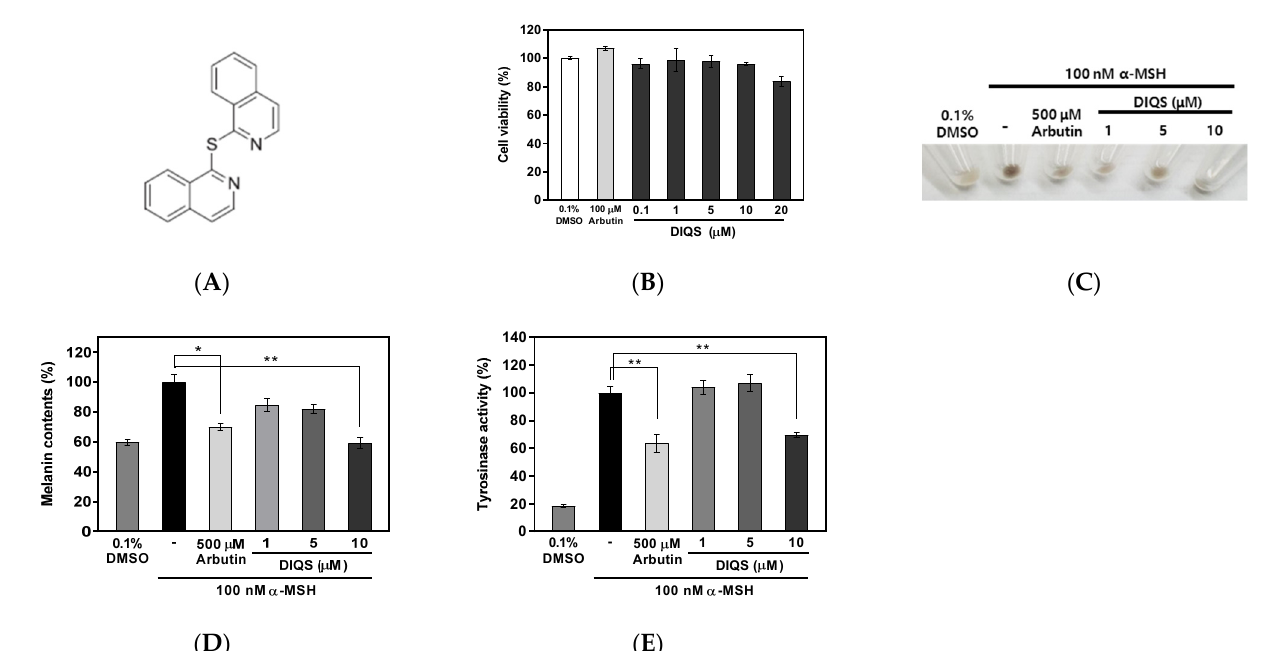
Figure 1. Di (isoquinolin-1-yl) sulfane (DIQS) induced an anti-melanogenic effect in B16F10 murine melanoma cells. ( A ) The chemical structure of DIQS is shown. ( B ) B16F10 cells were treated with various concentrations of DIQS for 48 h. The viability of B16F10 cells was determined using the Cell counting kit-8. ( C ) The cells were harvested to measure melanin content. Cell lysates were photographed prior to measurement of the melanin content. ( D ) Melanin content in B16F10 cells was significantly inhibited by DIQS treatments. ( E ) Tyrosinase activity induced by α -MSH was decreased in B16F10 cells at a concentration of 10 μ M after 48 h of DIQS treatment. DIQS inhibited tyrosinase activity in α -MSH-stimulated B16F10 cells. Data are means ± standard deviation (SD). * p < 0.05; ** p < 0.01 (vs. the α -MSH treated group).